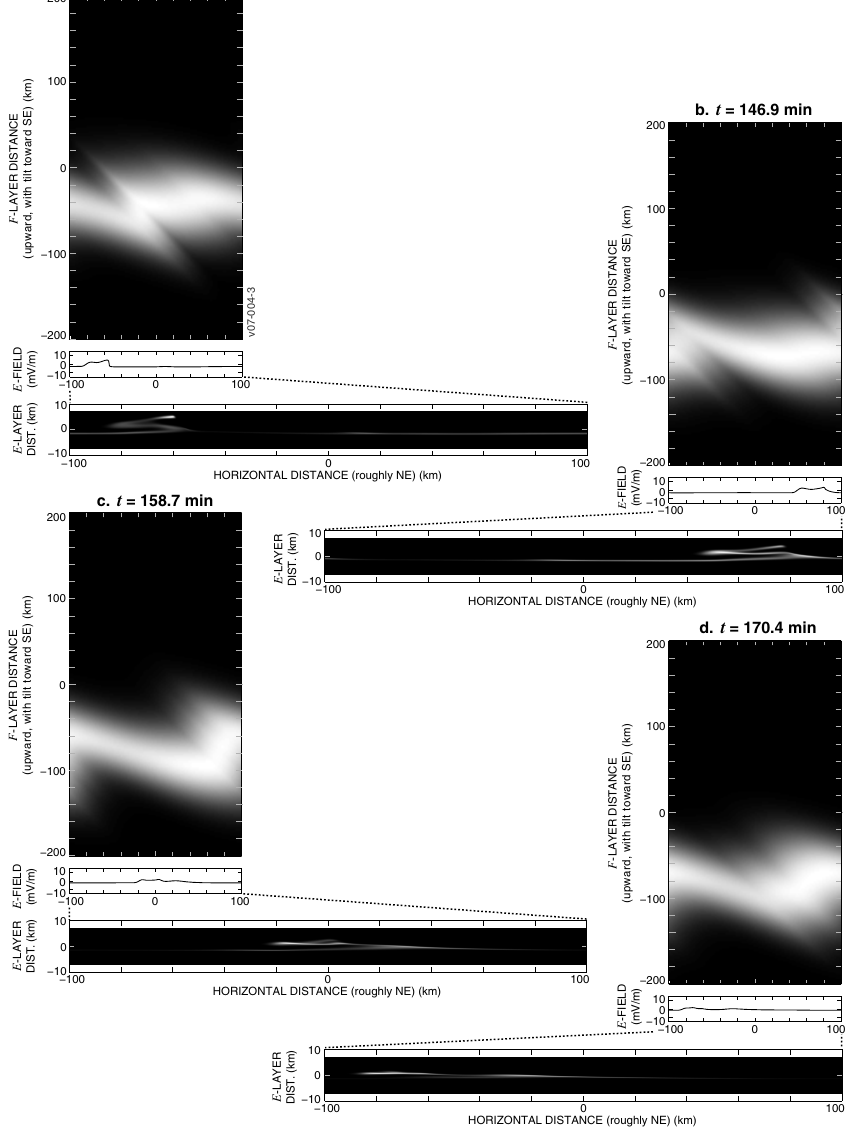
Figure 11: Continuation of the simulation in Figure 10.